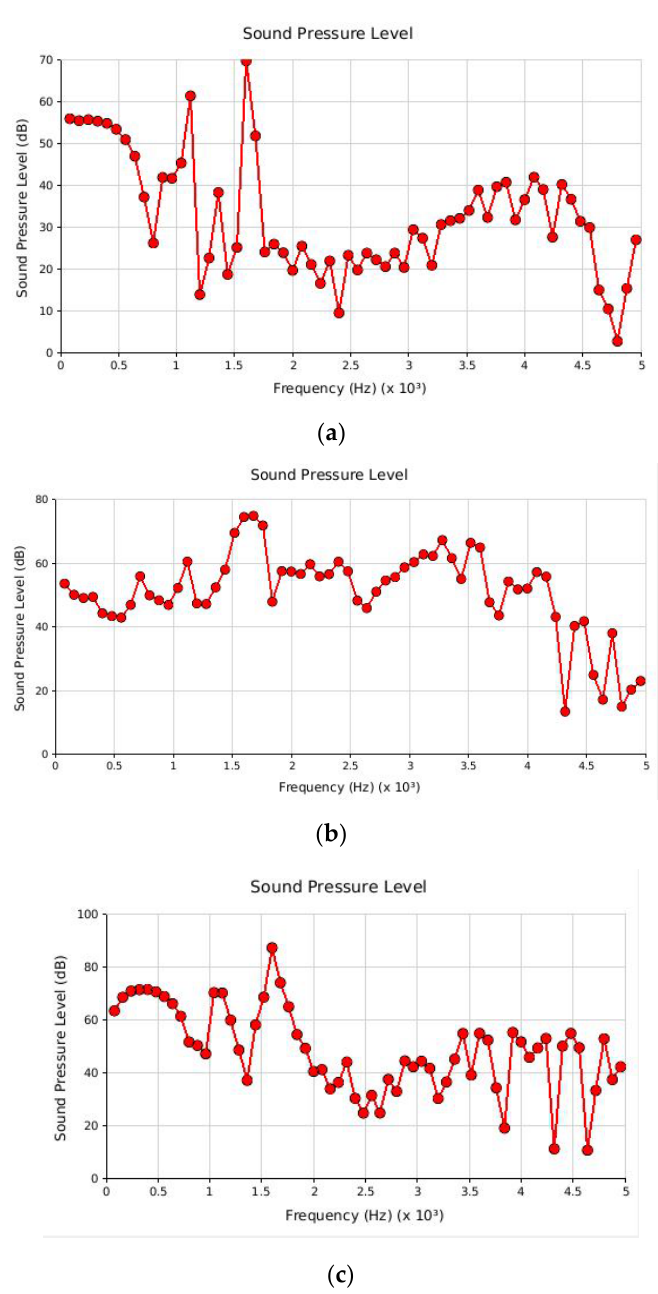
Figure 20. Stator system electromagnetic noise at 1600 rpm. ( a ) Electromagnetic noise at no load. ( b ) Electromagnetic noise at rated load. ( c ) Electromagnetic noise at peak load.